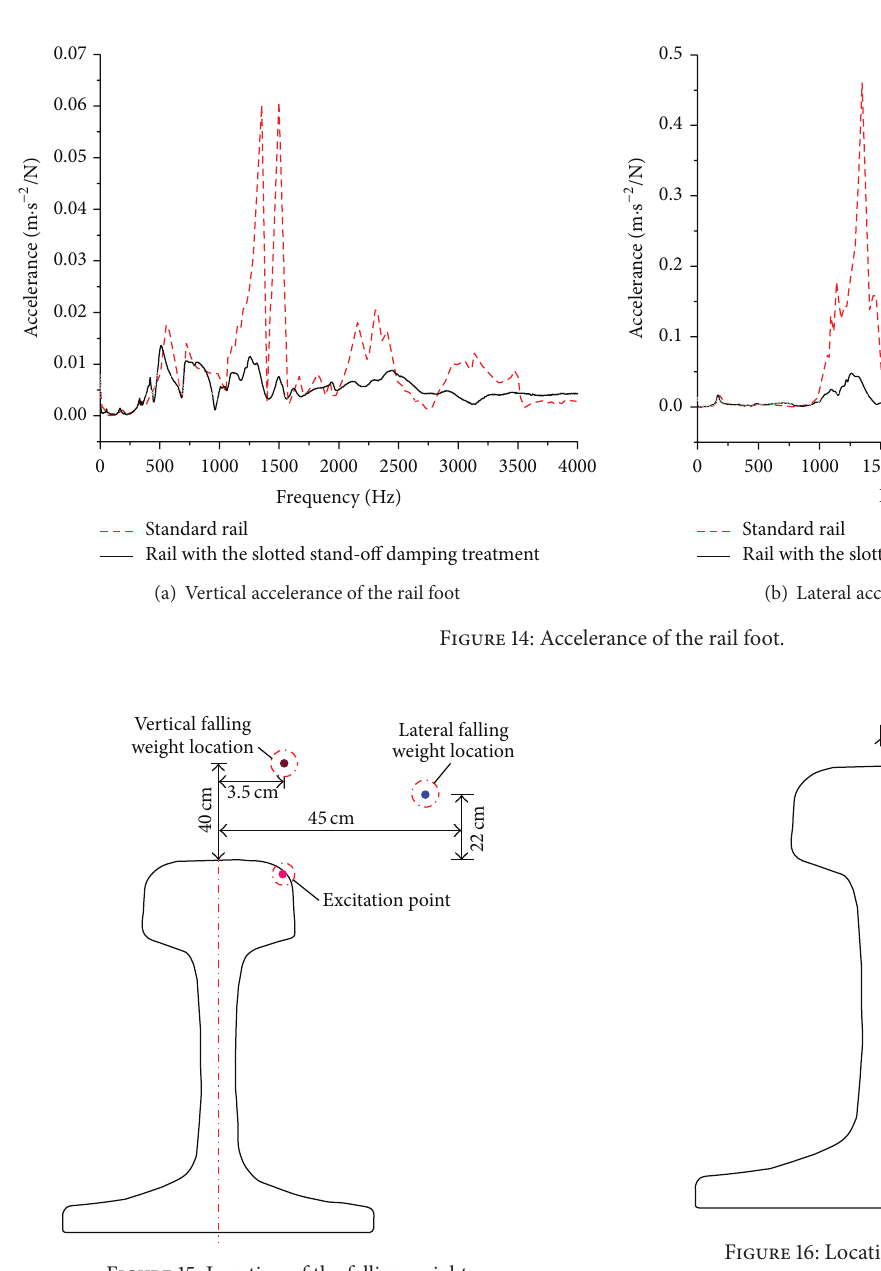
Figure 15: Location of the falling weight.